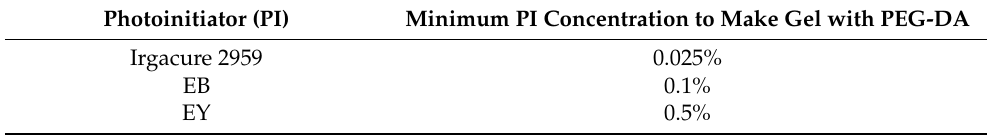
Table 1. Minimum PI concentration to make gel for the different PIs. Photoinitiator